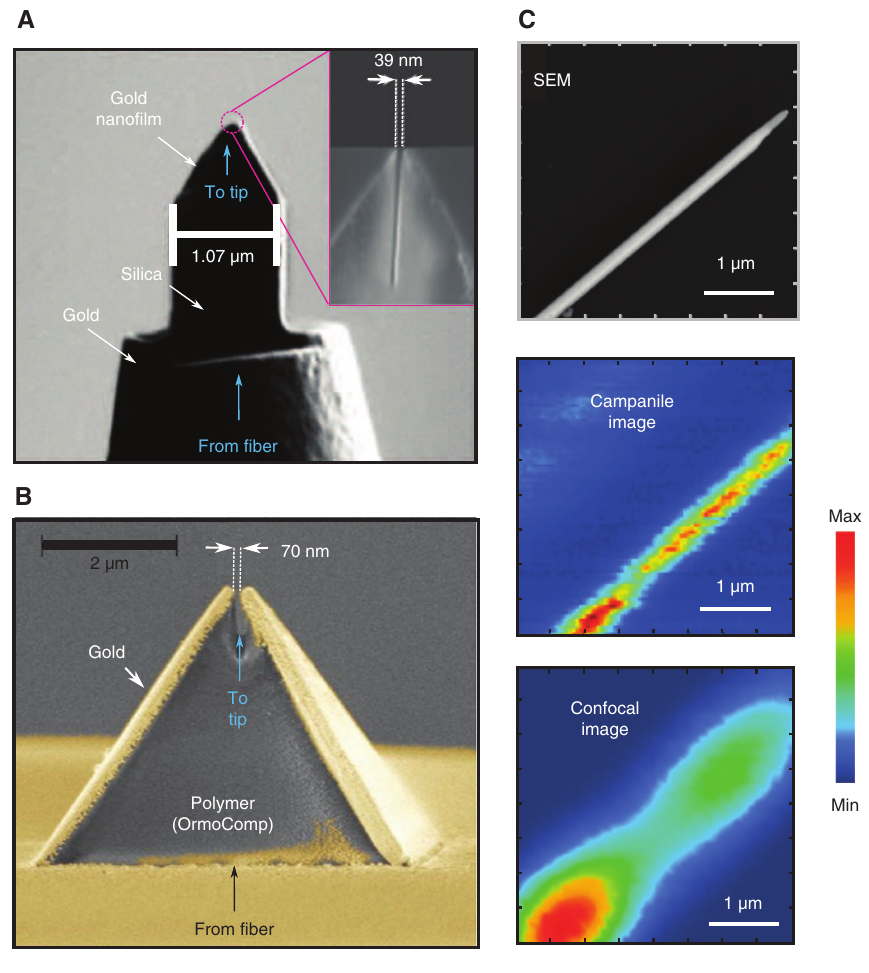
Figure 8: Campanile nanoconcentrator at the end of an optical fiber. (A) Campanile geometry that is composed of a tapered MIM waveguide fabricated at the end of a tapered glass fiber by FIB milling. From Ref. [58]. Reprinted with permission from AAAS. (B) More recent fabrication approach that uses nanoimprint lithography for mass produc- tion. Adapted from Ref. [75] under a Creative Commons CC BY. (C) Demonstration of nano-optical hyperspectral mapping of an InP nanowire using the campanile device (SEM image shown in the top image), showing that the campanile system provides much higher spatial resolu- tion (middle plot) than it can achieved using confocal microscopy (bottom plot). From Ref. [58]. Reprinted with permission from